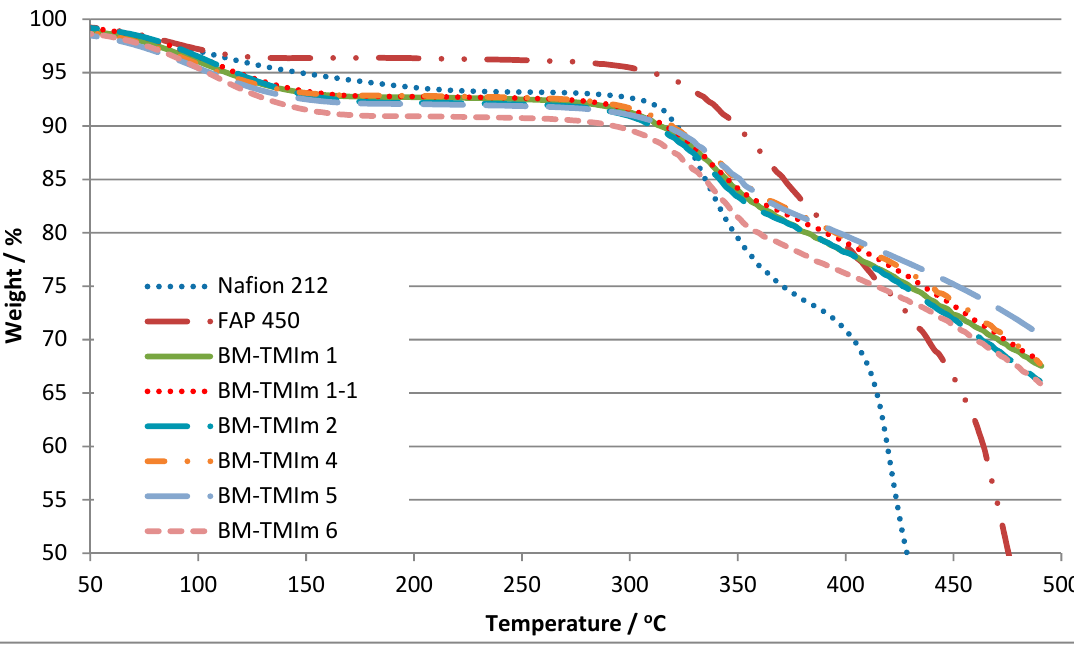
Figure 5. Thermal gravimetric analysis (TGA) traces of membranes in comparison to FAP 450 (anion-exchange membrane produced by Fuma-Tech) and to Nafion ® 212.